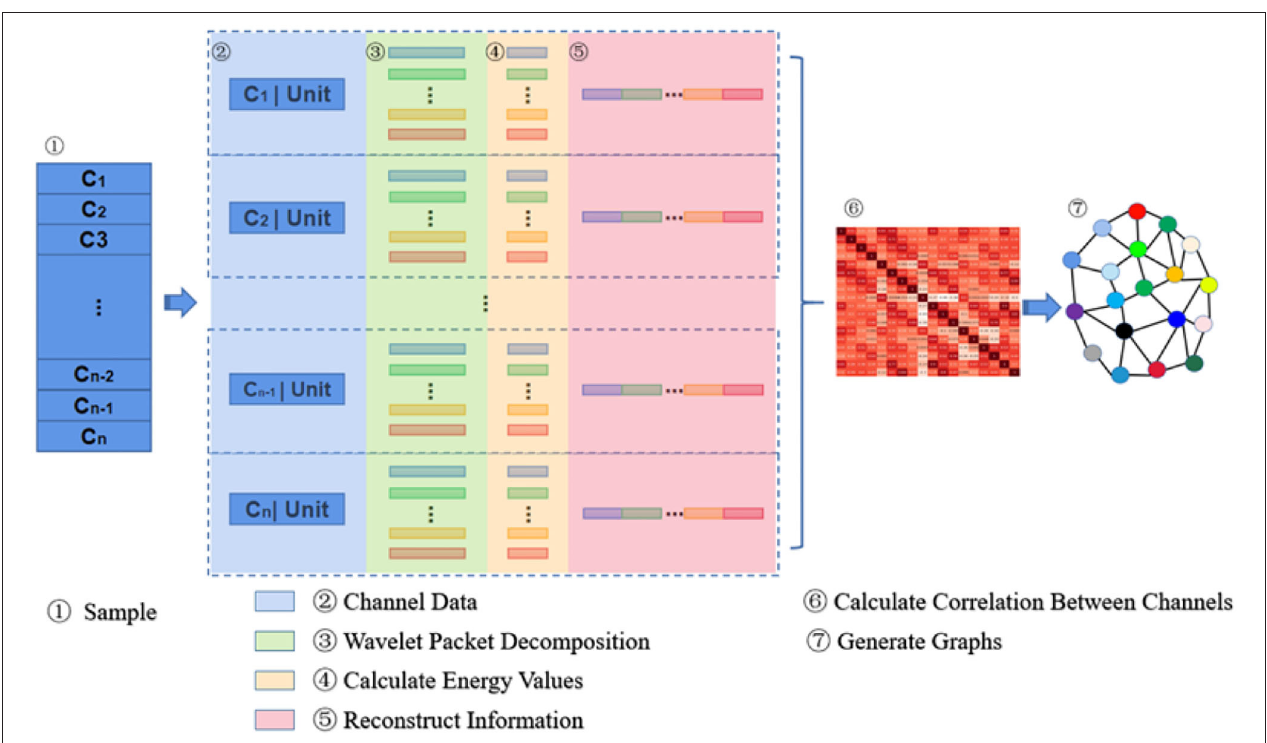
FIGURE 2 | The figure shows concrete principle of information reconstruction space.